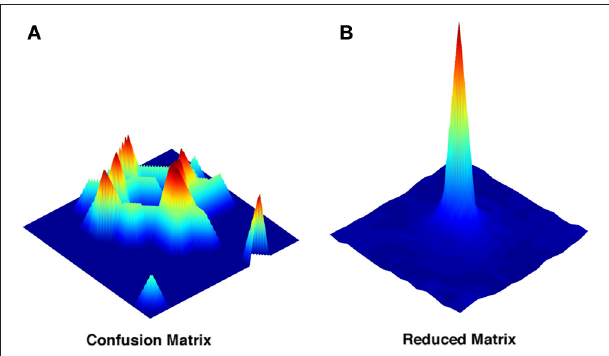
FIGURE 2 | Representative examples of the full and of the reduced confusion matrix. (A) Decoding probability distribution for a single location extracted from the complete confusion matrix. (B) Decoding probability distribution obtained from the reduced matrix. Both are obtained with a sample size of N = 4. Color coding just reflects the relative heights of the points in the probability distributions.